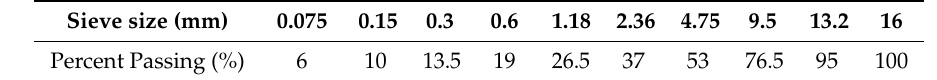
Table 4. Aggregate gradation of